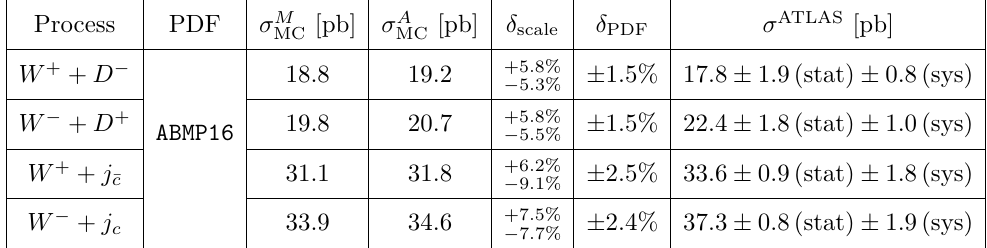
Table 4 . Our predictions for the integrated fiducial NLO + SMC cross sections for W ± + D ∓ and √ W ± + j c ( j ¯ c ) production according to the s = 7 TeV ATLAS analysis of ref. [21]. PS, hadronization, MPI and beam remnant effects are accounted for using either the Monash tune (third column) or the ATLAS A14 central tune (fourth column). Also reported, for the simulations with the ATLAS A14 central tune, are the uncertainties stemming from scale and PDF variation, both computed using as a basis the ABMP16_3_NLO PDF fit, as well as the ATLAS experimental